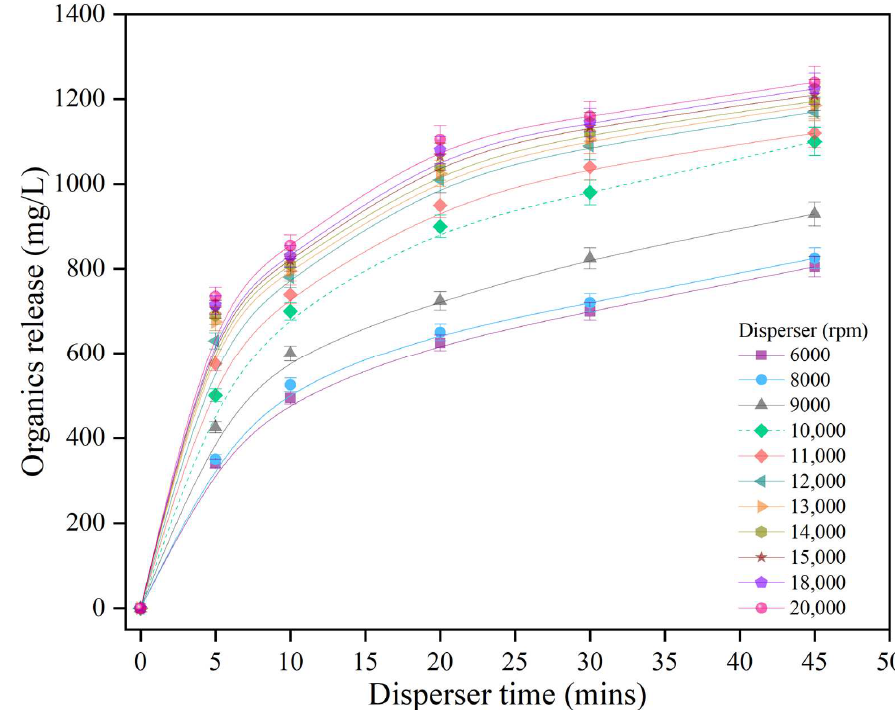
Figure 2. Effect of disperser time on organics release.